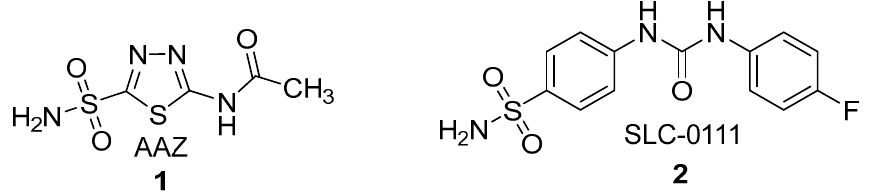
Figure 1. Chemical structures of clinically used diuretic AAZ ( 1 ) and CA IX inhibitor under clinical trial on diarylcarbamide scaffold ( 2 ). trial on diarylcarbamide scaffold ( 2 ).